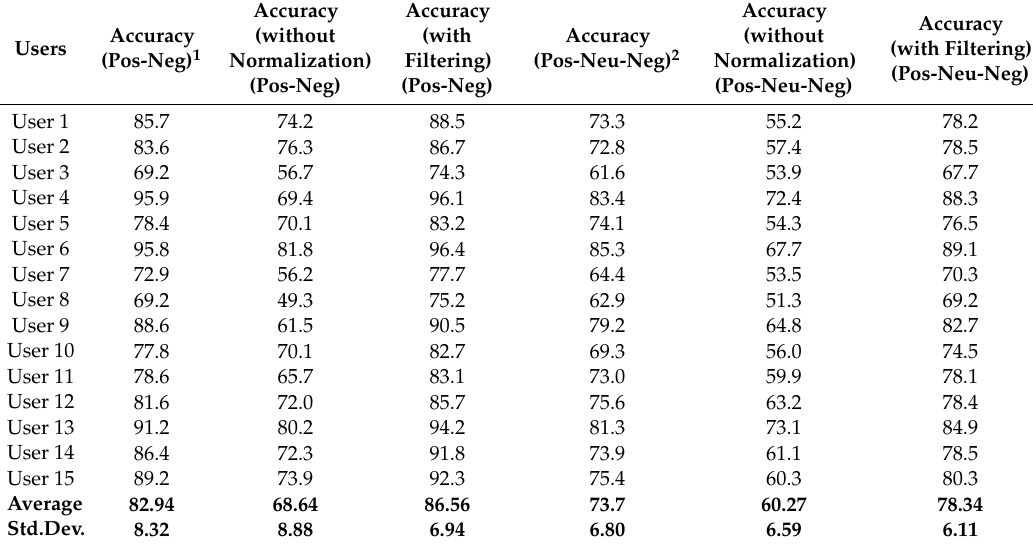
Figure 6. An example of network training. Table 3. “One subject out” classification accuracies for the SEED dataset.